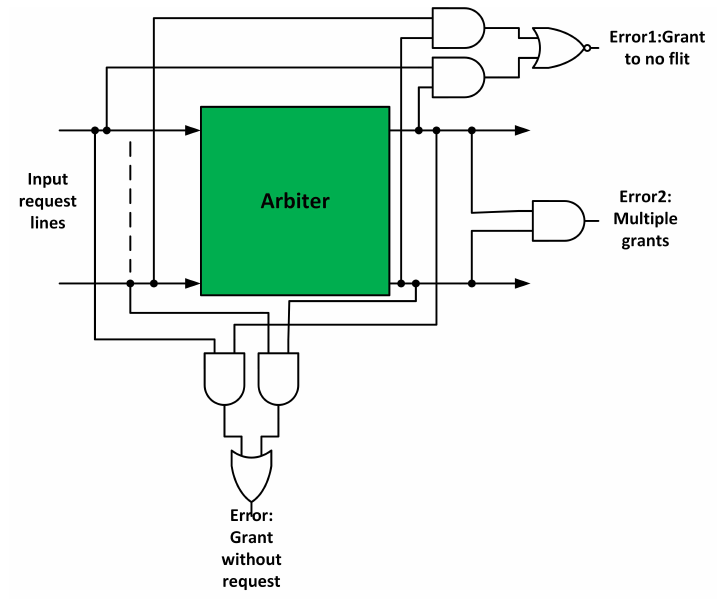
Figure 8. Arbiter fault detection mechanism.